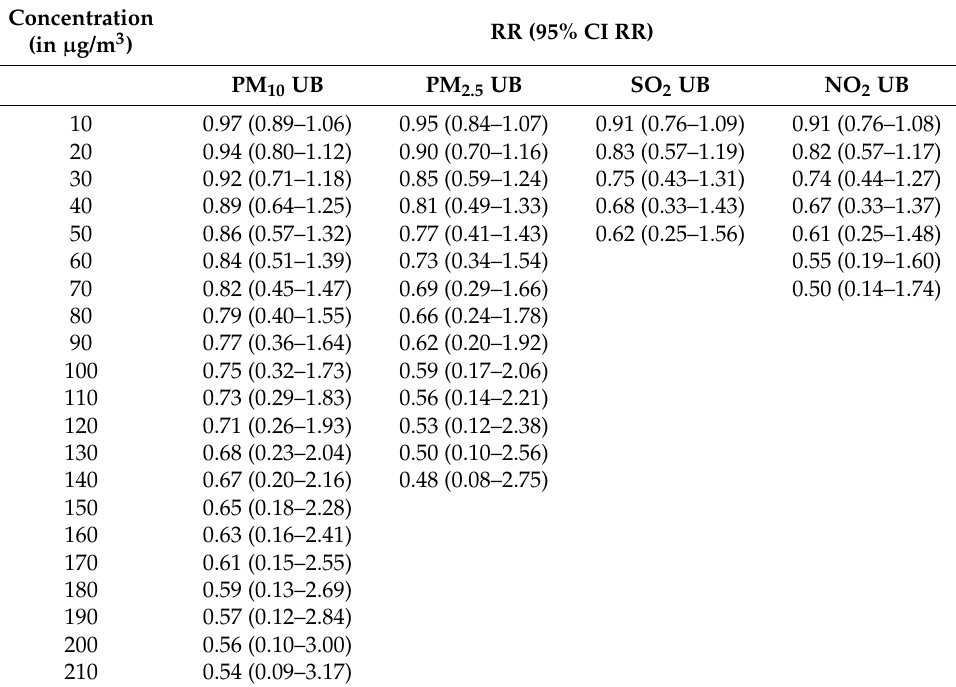
Table 3. RR of AECOPD hospitalization for each 10 µ g/m 3 increase in selected air pollutants (single- predictor